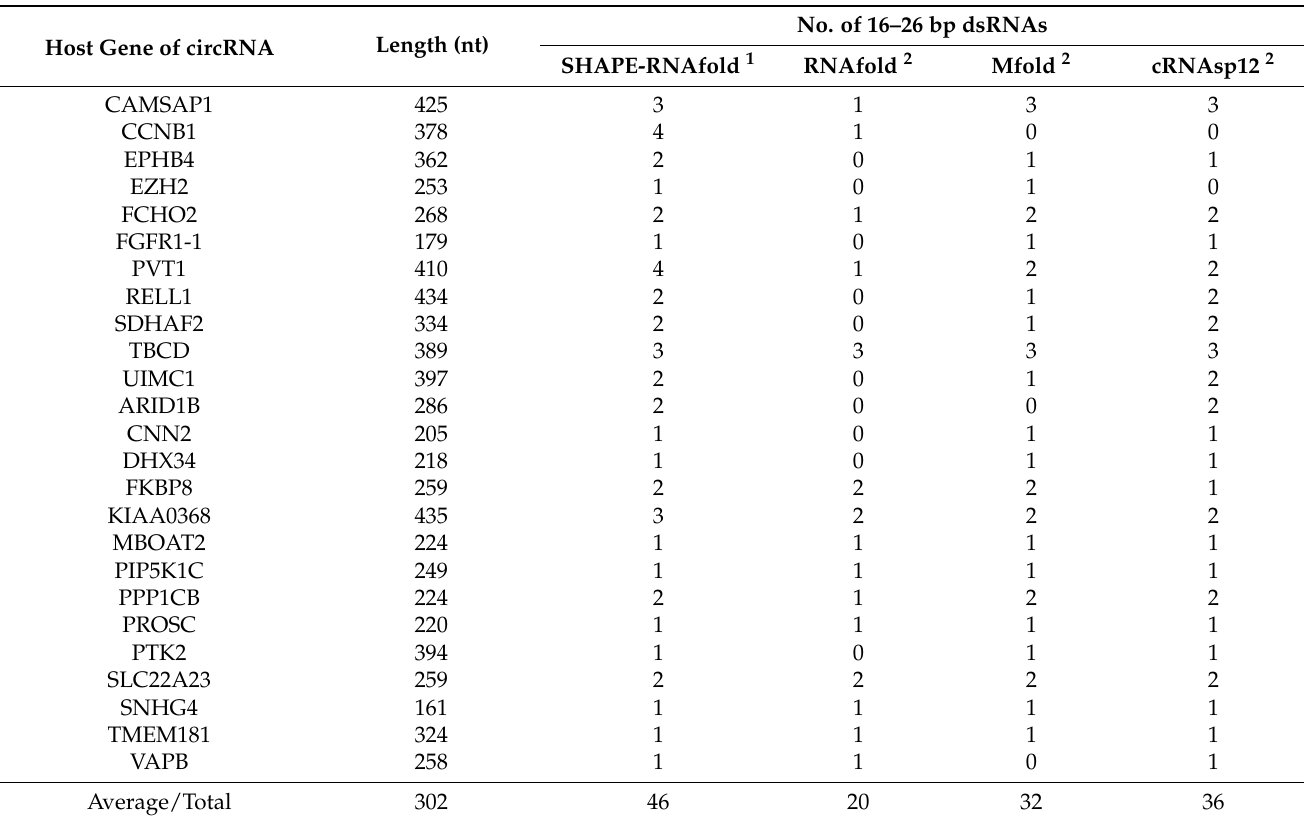
Table 1. Performance of the cRNAsp12